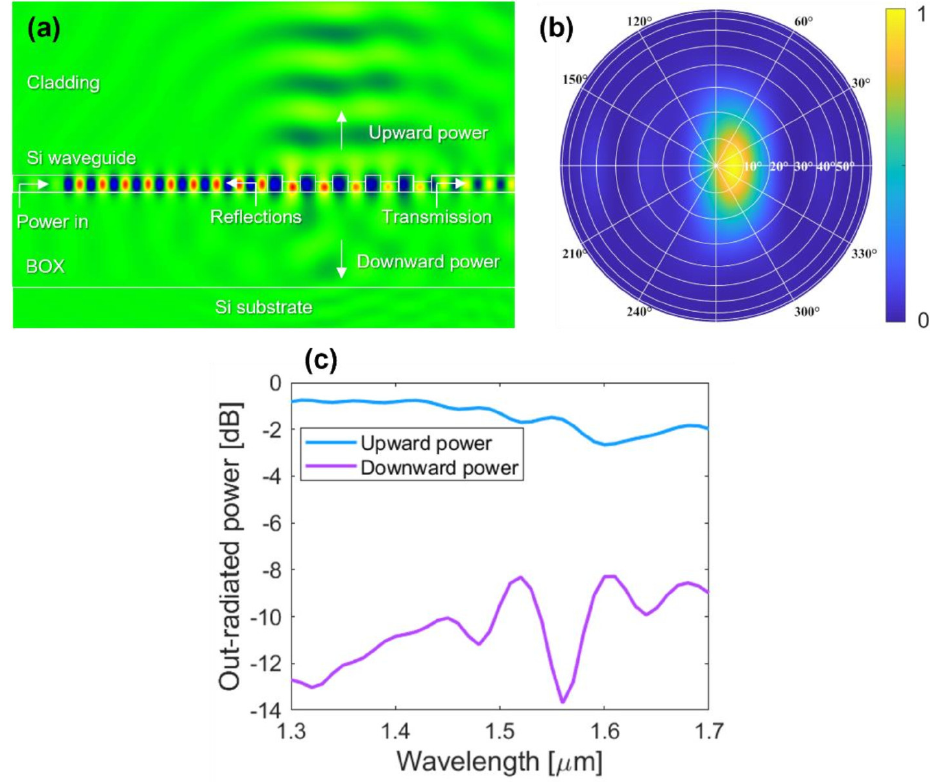
Figure 5. ( a ) Electric field distribution (the real part of E y field component) of the L -shaped optical antenna. ( b ) The antenna far-field pattern, radiating at 1550 nm wavelength. ( c ) Out-radiated power (power up and down) from optical antenna as a function of the wavelength.